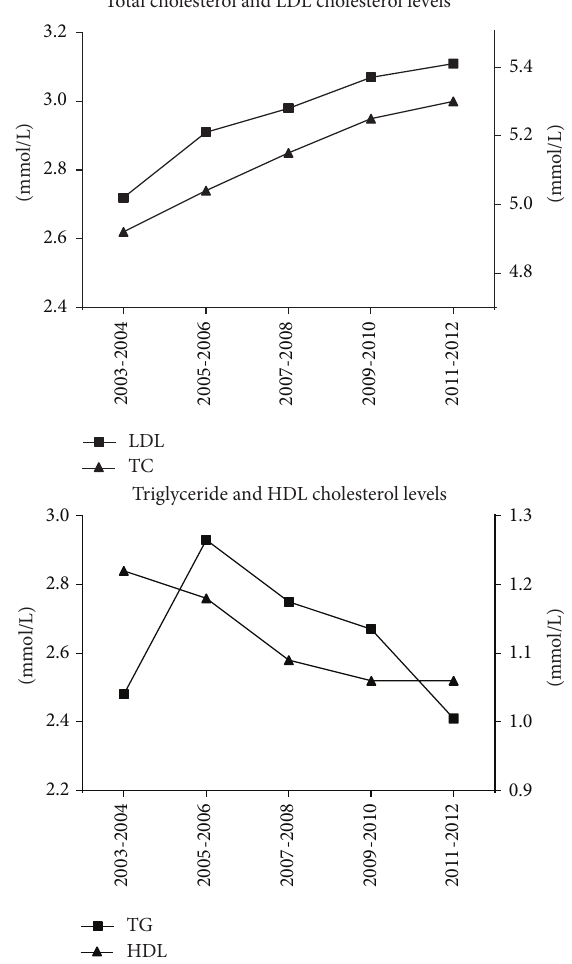
Figure 1: Trends in serum total cholesterol, LDL cholesterol, triglyceride, and HDL cholesterol levels between 2003 and 2012.